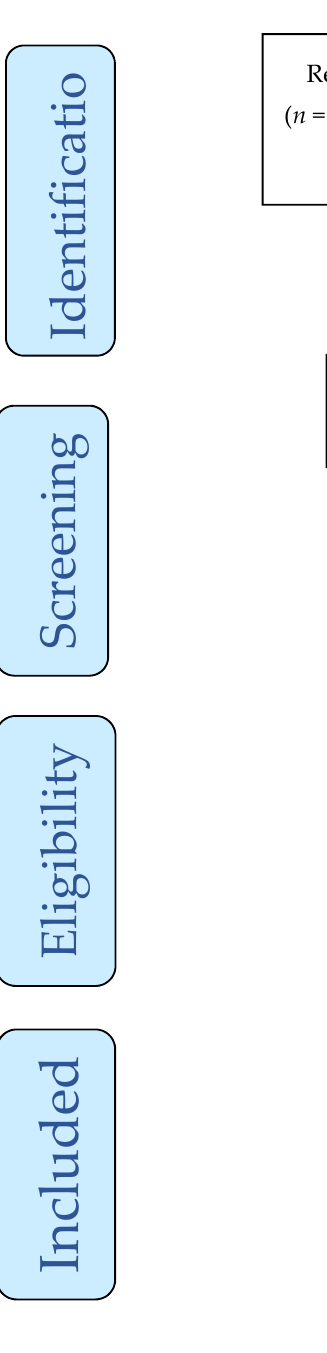
Figure 1. PRISMA flowchart with the search strategy of the systematic review.